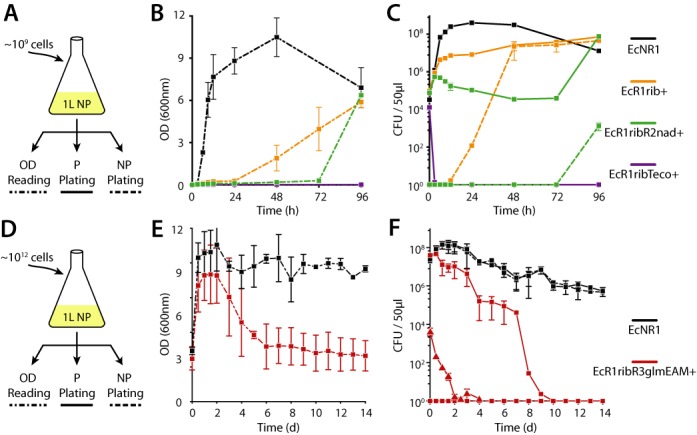
Large volume and long-term challenge of multilayered safeguard strains. (A) Strains grown in permissive (P) media to ∼109 cells then challenged over 96 h in 1 l of non-permissive (NP) media, which is monitored for cell density (OD) (B) and cell viability (CFU) on permissive (solid line) and non-permissive (dotted line) solid plates (C). Biological triplicate results for control strain (EcNR1, black), 2-layer strain (EcR1rib+, orange), 3-layer strain (EcR1ribR2nad+, green) and 3-layer bacteriotoxic strain (EcR1rib[Teco]+, purple) plotted. (D) Control (EcNR1, black) and 4-layer safeguard (EcR1ribR3glmEAM+, red) strains grown in permissive, then challenged in 1 l of non-permissive media. (E) Strains were monitored by OD readings (F) and by plating on permissive or non-permissive solid media over 14 days (squares, ∼1012 cell inoculum) or 5 days (triangles, ∼108 cell inoculum). No colonies were observed on NP media for the 4-layer strain.